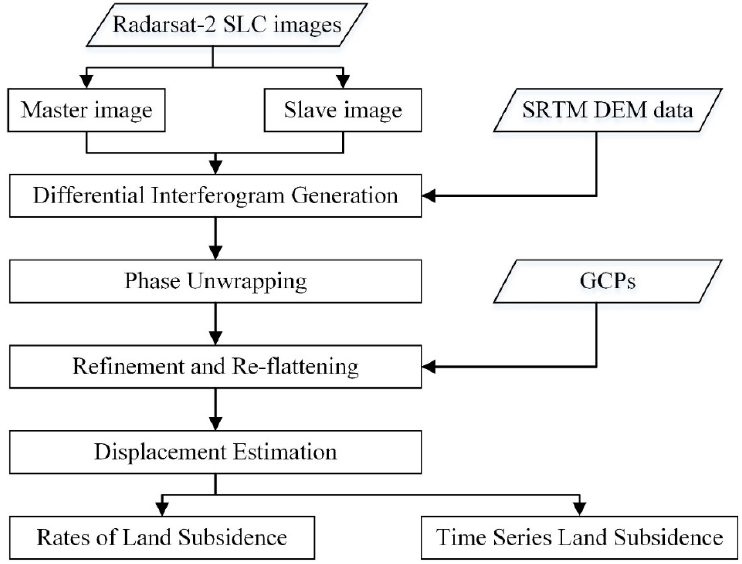
Figure 2. Flowchart of SBAS-InSAR data processing.